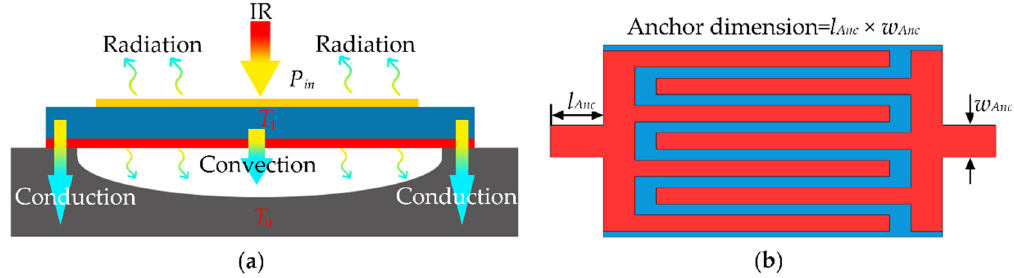
Figure 12. ( a ) Schematic diagram of heat transfer of the detector with Mo / AlN anchors; ( b ) schematic